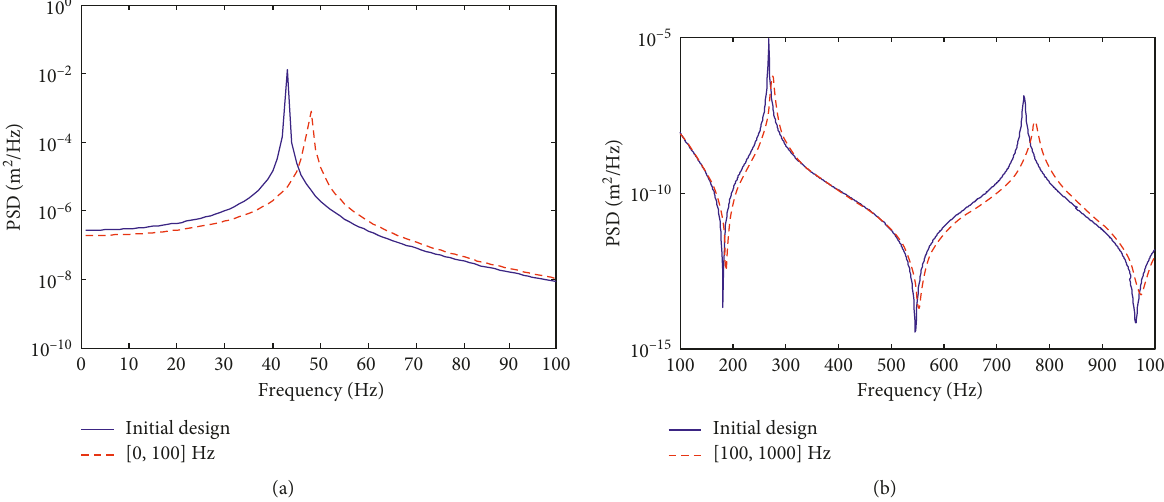
Figure 5: PSD curves of the initial and optimal design of CLD treatment. (a) f